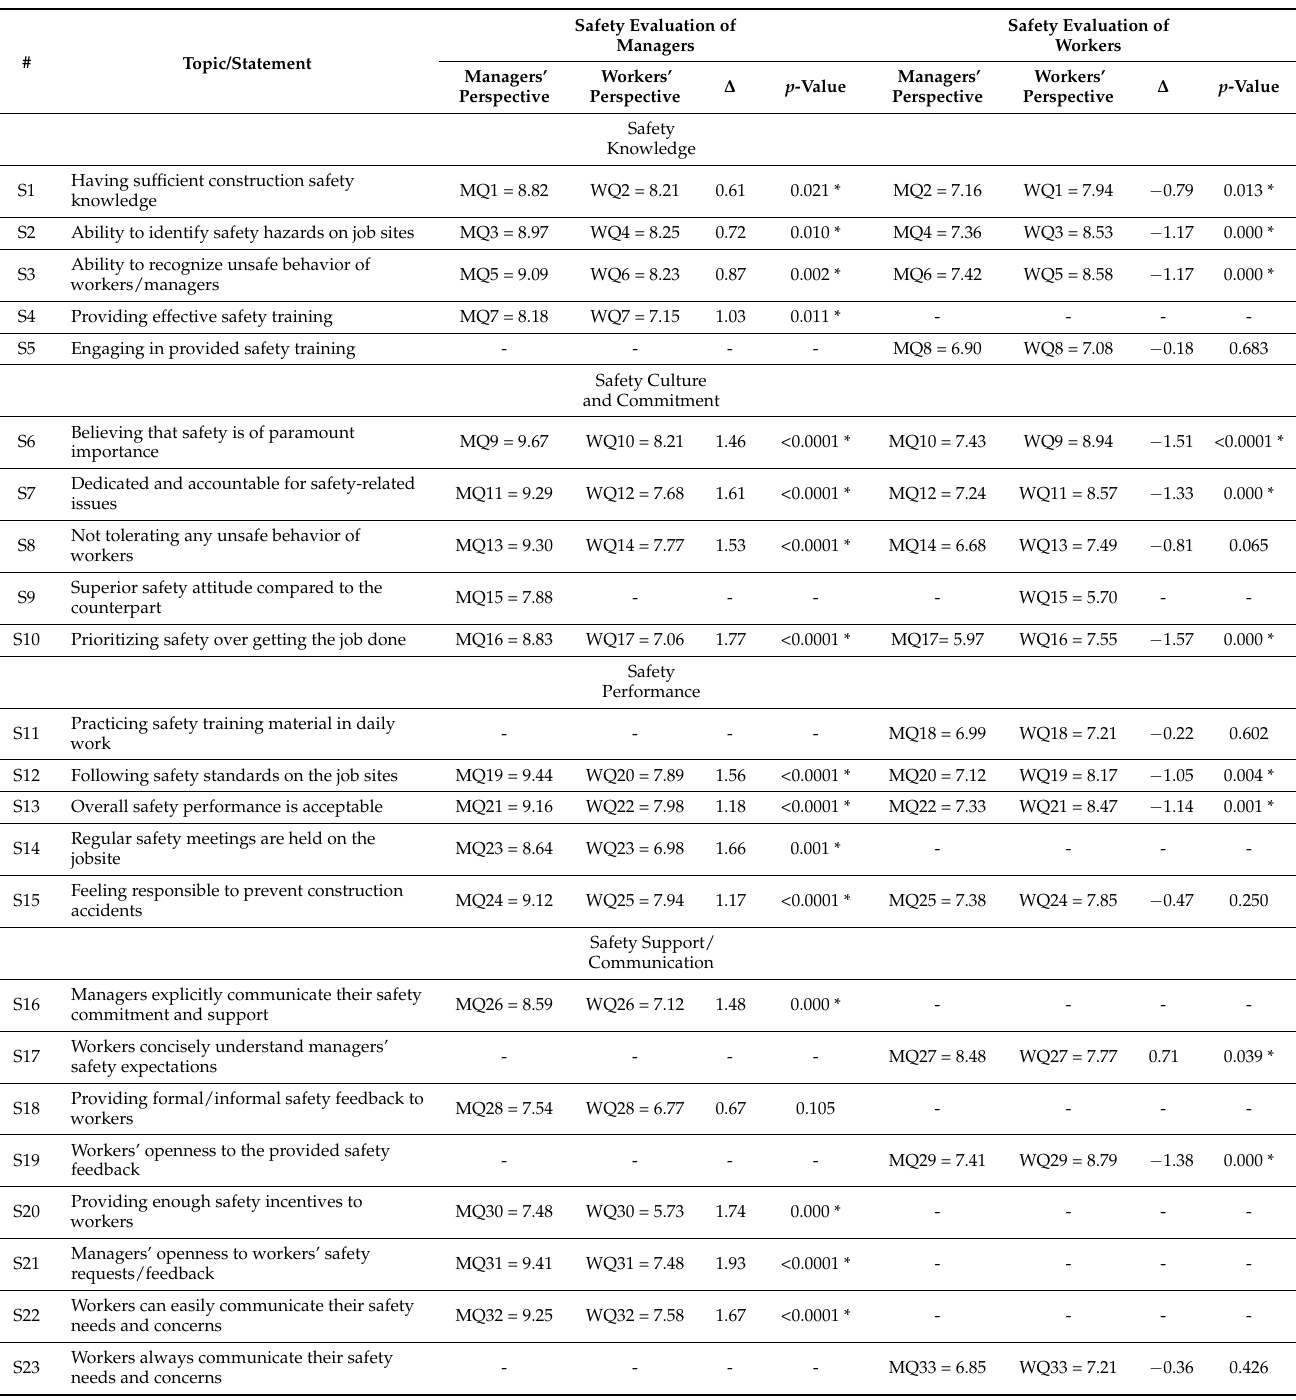
Table 8. Results of comparing managers’ and workers’ self-assessments with their corresponding